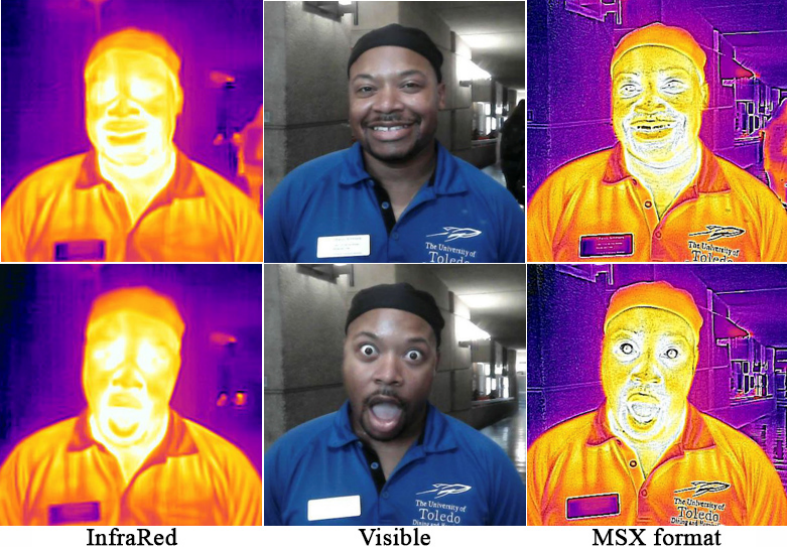
Figure 5. Sample image of a subject for happy and surprise emotions in the proposed VIRI